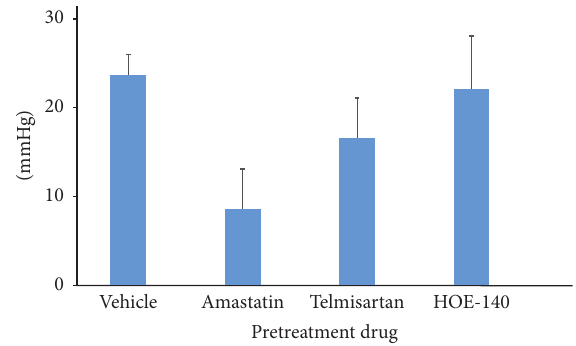
Figure 6: The pressor response of lower dose of aminopeptidase A (APA). Wistar-Kyoto rats received icv administration of 200 ng of APA following treatment of aCSF ( 𝑛 = 4 ) or each blocker. The pressor response of lower dose of APA seemed to be smaller in 800 nmol of amastatin ( 𝑛 = 3 ) than in 80 𝜇 g of telmisartan ( 𝑛 = 2 ) or 1nmol of HOE-140 ( 𝑛 = 2